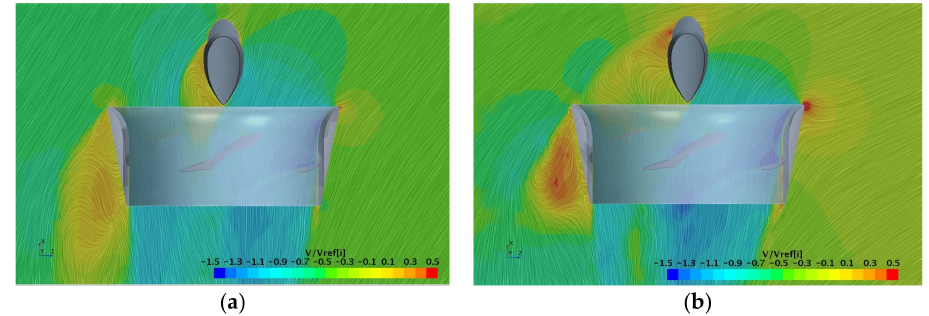
Figure 14. Examples of flow pattern around propulsor at large heading angles, J = 0.6: ( a ) − 35 degrees; ( b ) − 60 degrees. View from